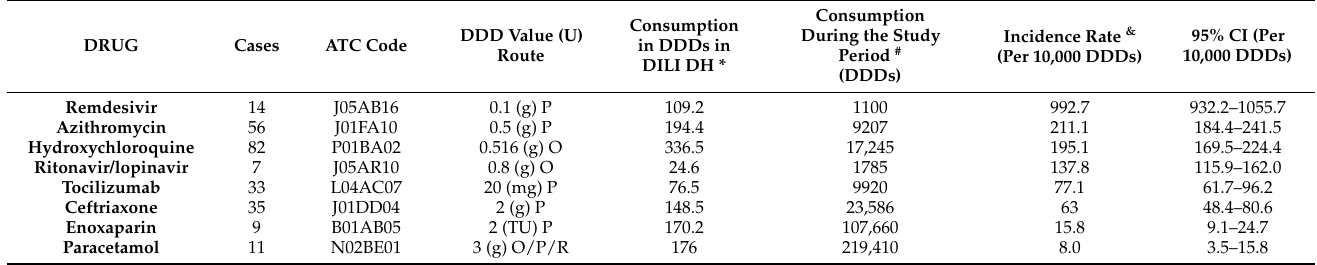
Table 5. Incidence by consumption in cases of in-hospital DILI.